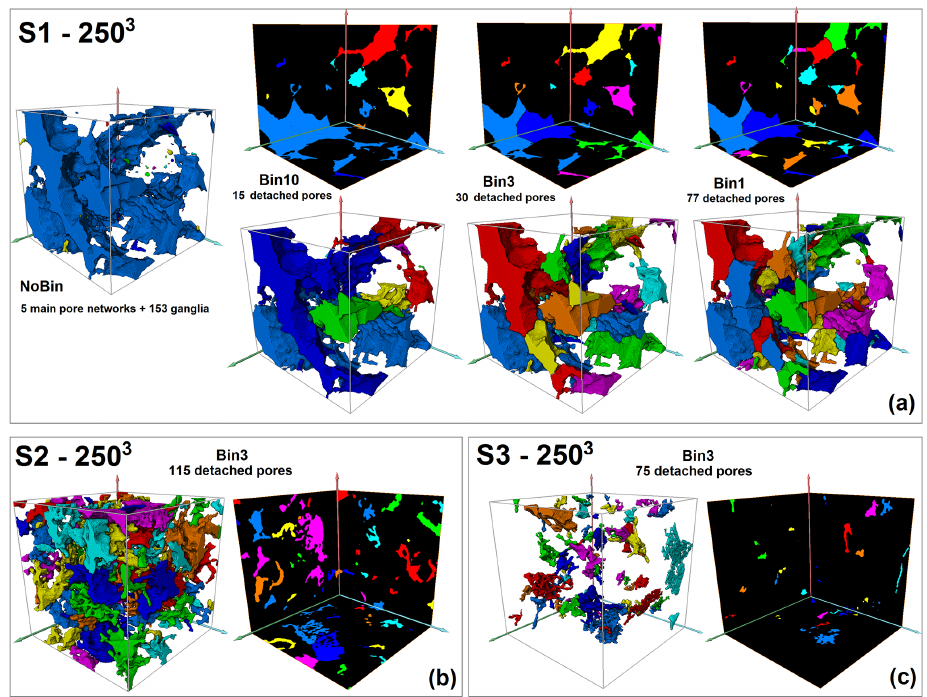
Figure 4. 3-D and 2-D visualizations after the watershed algorithm is applied to the 250 3 voxel volume of S 1 (a) , S 2 (b) , and S 3 (c) , with the labeled images showing distinct colors for dissimilar